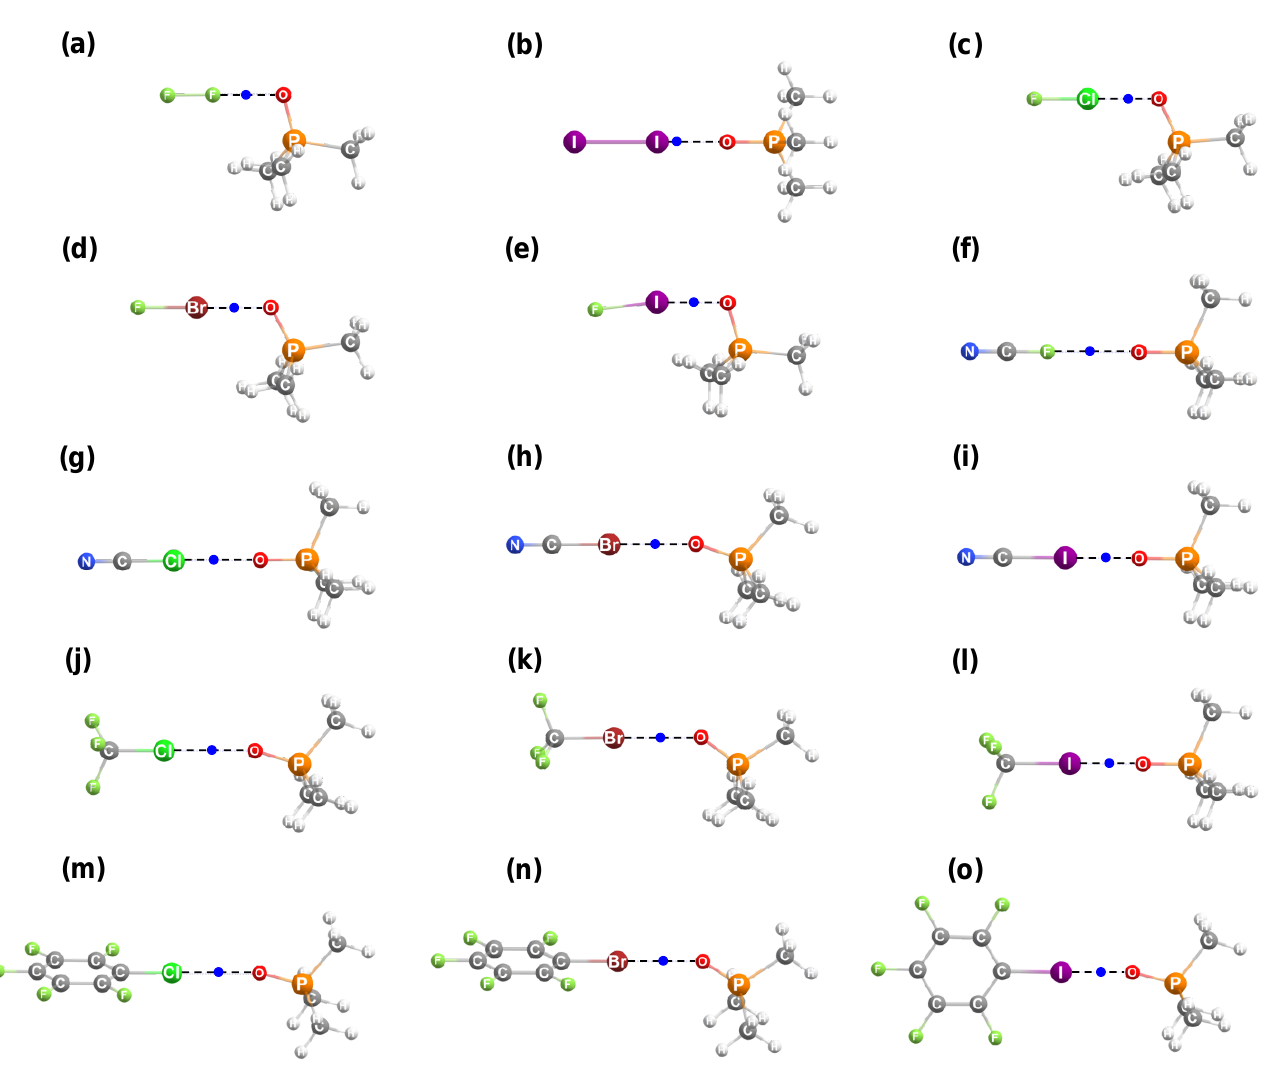
Figure 3. Some examples of optimized geometries of halogen-bonded complexes formed between ( a ) F 2 ; ( b ) I 2 ; ( c ) ClF; ( d ) BrF; ( e ) IF; ( f ) FCN; ( g ) ClCN; ( h ) BrCN; ( i ) ICN; ( j ) CF 3 Cl; ( k ) CF 3 Br; ( l ) CF 3 I; ( m ) C 6 F 5 Cl; ( n ) C 6 F 5 Br; ( o ) C 6 F 5 I and Me 3 PO considered in this work. Blue dot marks the position of